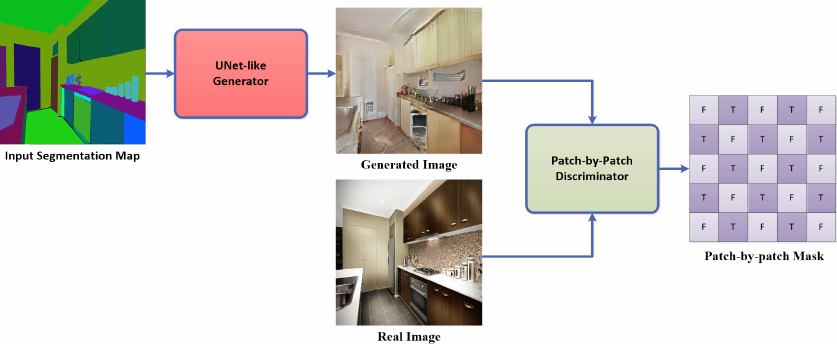
Figure 1. Overview of the proposed paired Image-to-Image translation